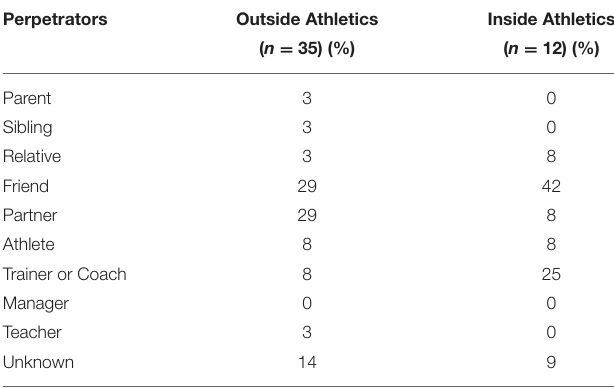
TABLE 6 | Mean age for first incident of verbal, physical, or sexual abuses outside and inside the Athletics setting. Outside Athletics (year) Inside Athletics (year)